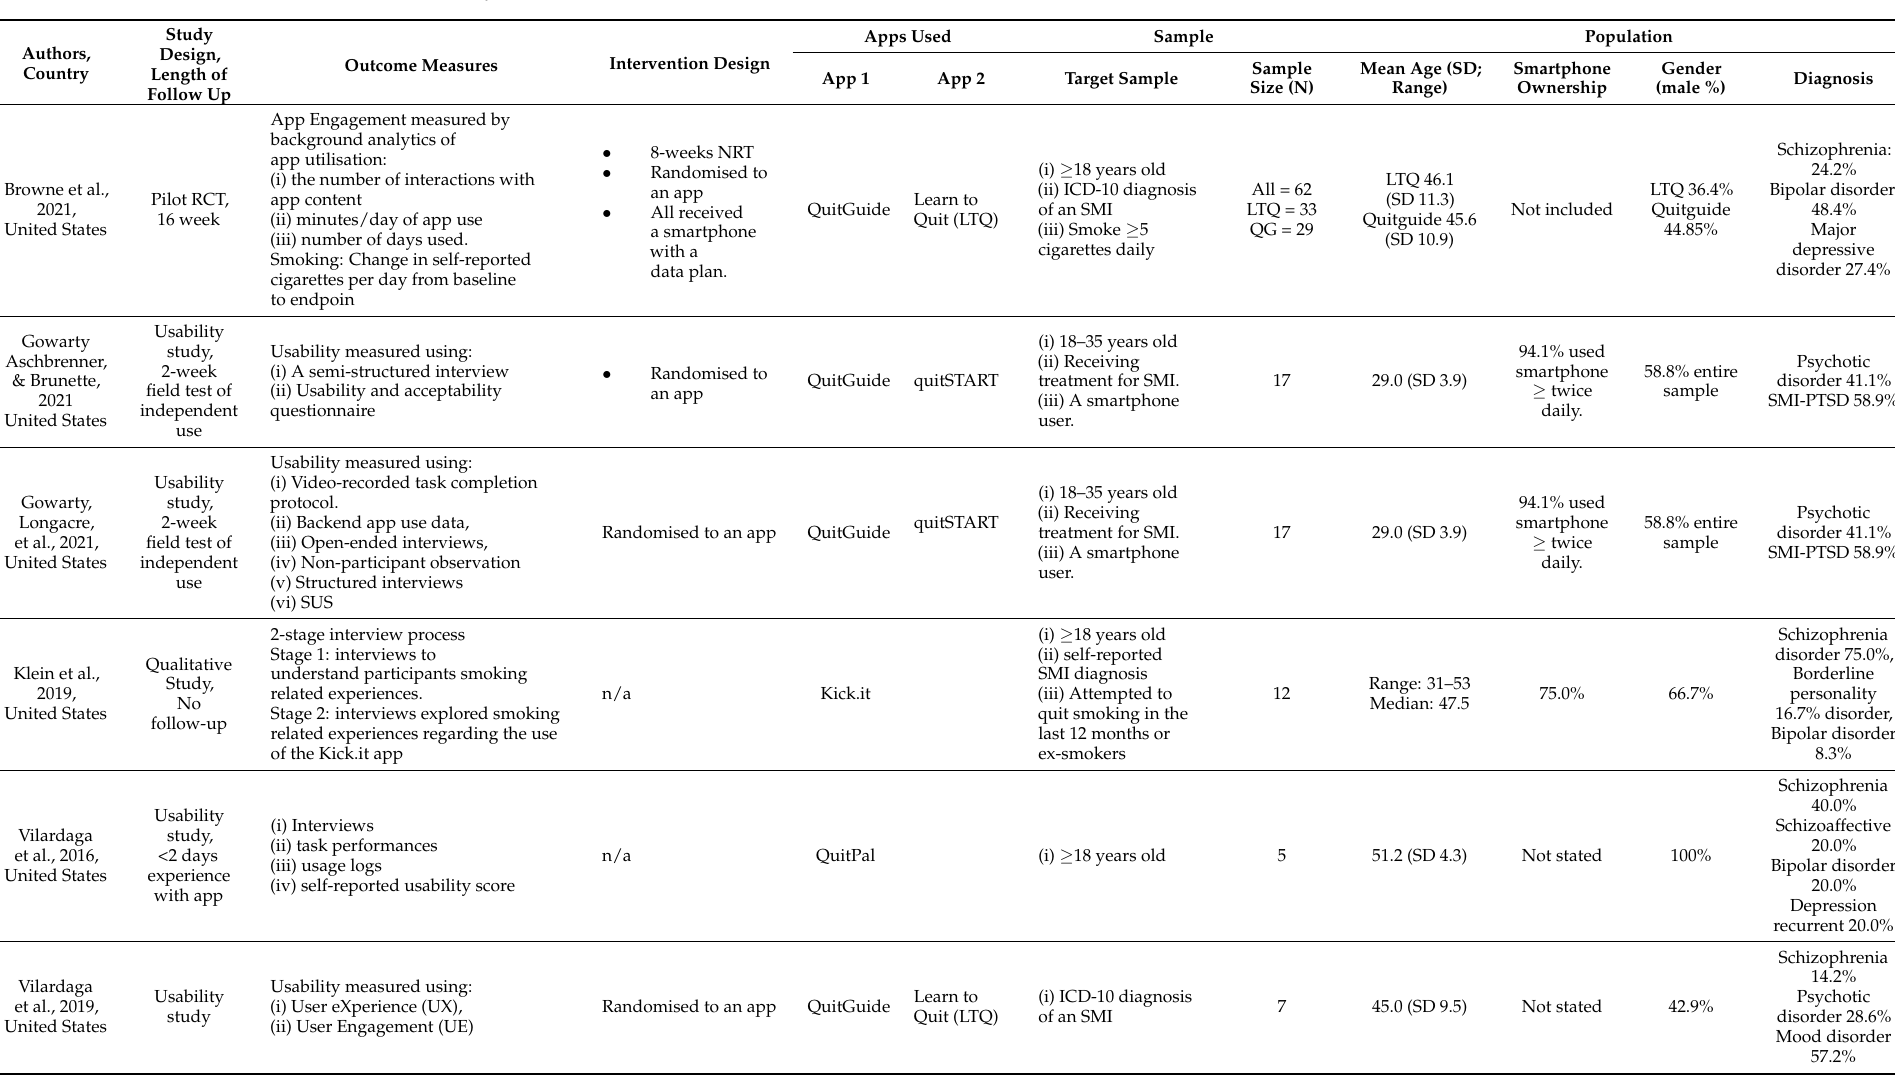
Table 1. Summary of each of the studies included in the